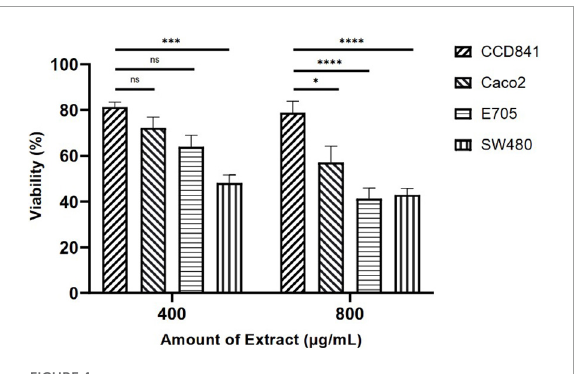
FIGURE4 MTT viability assays on four cell lines treated with Camelina sativa extracts at two concentrations by 2-way analysis of variance (ANOVA) statistical analysis (ns, not significant, * = p < 0.05, *** p < 0.001, and **** p <